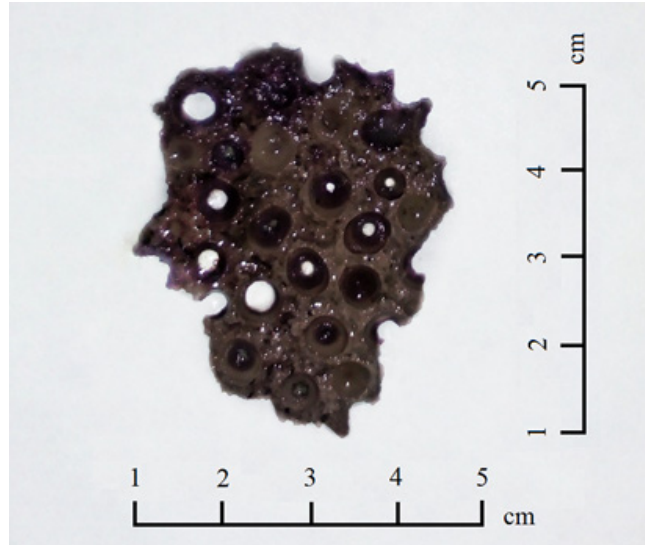
Figure 3. A photograph of the sludge after sulfuric leaching of ilmenite in the presence of sodium